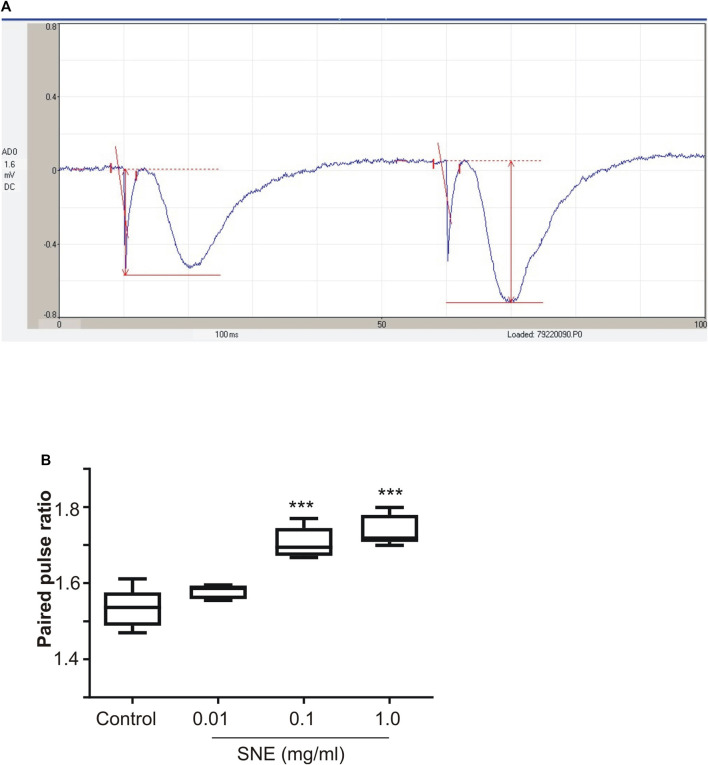

(A) A typical recording of paired fEPSP showing pair-pulse facilitation (B) Effect of SNE (0.01, 0.1, and 1.0 mg/ml) on paired pulse ratio in rat hippocampal slices after a stable baseline perfused with normal aCSF. Data is mean ± SEM (n = 5). ***p < 0.001 compared with baseline, one-way ANOVA followed by a Dunnett’s multiple comparison test.